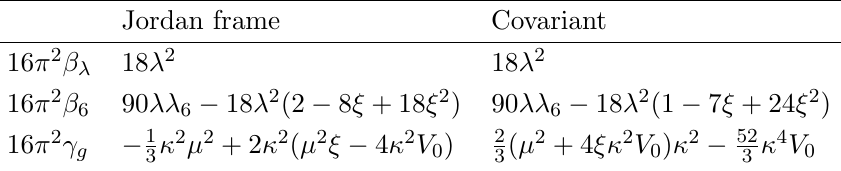
Jordan frame Covariant 16 (cid:25) 2 (cid:12) (cid:21)